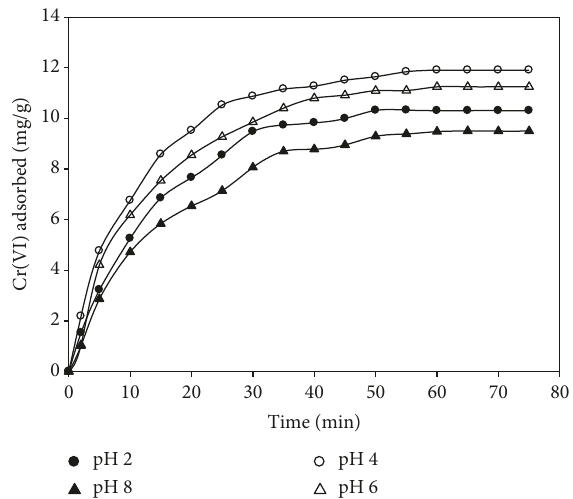
Figure 5: Effect of contact time at different pH. Biosorbent dose 0.8g/L; T 25 2 ° C; initial Cr(VI) concentration (cid:31) ±